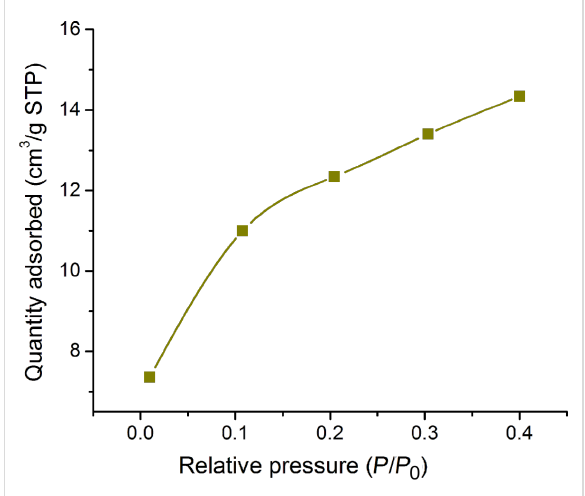
Figure 10: Degradation of rhodamine B by UV irradiation at 0.8 mg/mL catalyst loading.